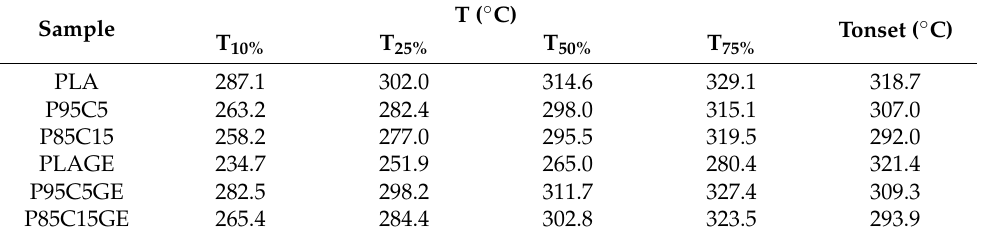
Figure 2. TGA curves. In ( A ): (I) PLA, (II) P95C5, and (III) P85C15. In ( B ), (I) PLAGE, (II) P95C5GE, and (III) P85C15GE. and (III) P85C15GE. Table 2. Temperatures at 10%, 25%, 50% and 75% weight loss obtained by